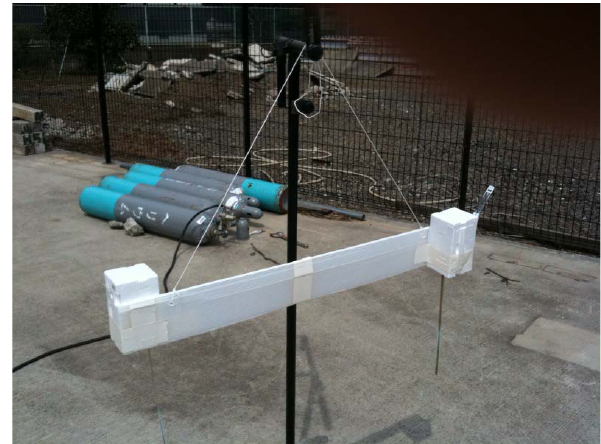
Fig. 5. Configuration of the dual launch of tungsten sondes for ex- amining the radiosonde package box contamination.